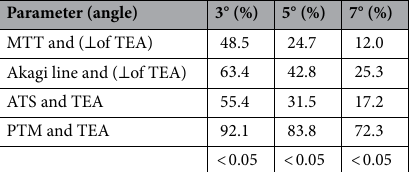
Parameter (angle)